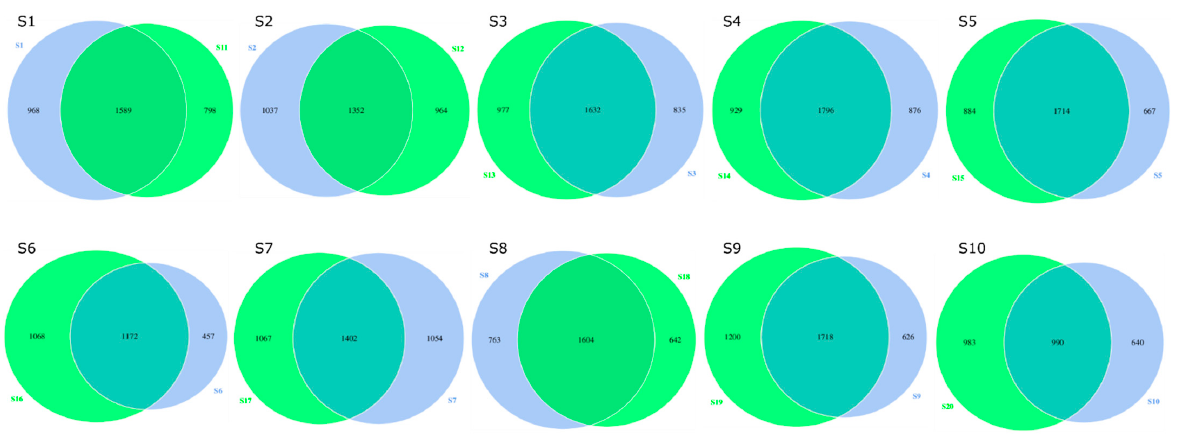
Figure 5. Venn diagram of identified microbial species. One sample or group is represented by each circle. Values in overlapping parts represent commonly observed species. The others are specific observed species in each sample. The blue color circle represents observed species in monsoon (August). The green color circle represents observed species in dry (March) season.